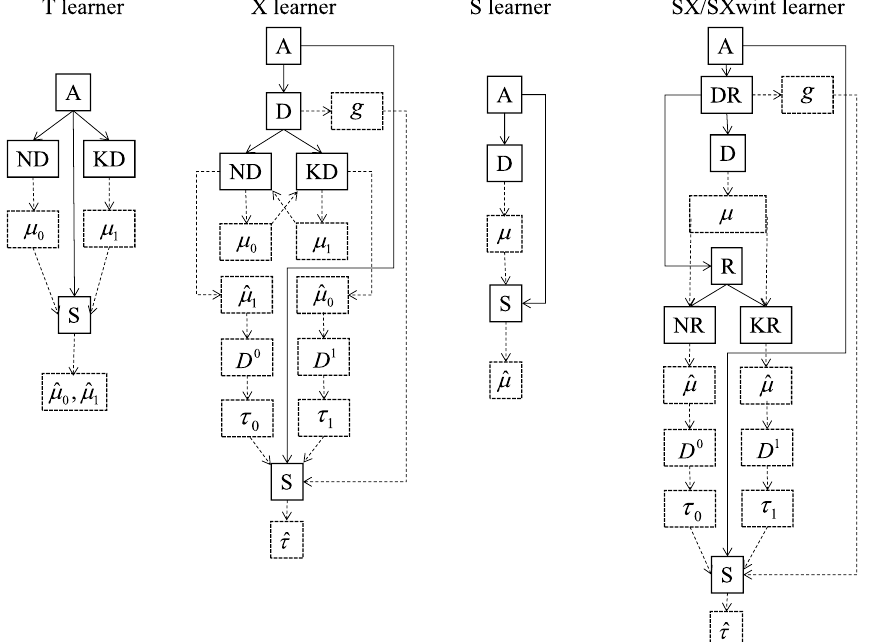
Figure 2. Illustration of metaalgorithms. D : Training data. S : Testing data. R : Re-training data. A : The set of all individuals. DR : The union of training and re-training data. N : The set of all individuals with treatment observation T = 0. K : The set of all individuals with treatment observation T = 1. ND : Training data from N. NS : Testing data from N. NR : Re-training data from N. KD : Training data from K. KS : Testing data from K. KR : Re-training data from K. Solid lines represent random splits of datasets. Dotted lines stand for the computational processes of